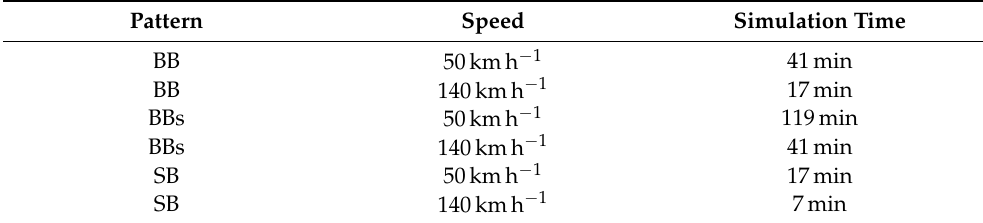
Figure 8. FE model with the roadway as master and the tread block as slave. A Top is the top side of the tread block. The simulation time depends strongly on the pattern used and especially on the driving speed, since the contact time increases inversely proportional to the driving speed. Simulations with one core and an Intel(R) Xeon(R) Gold 6134 CPU (3.2 GHz) result in the simulation times shown in Table 2. The increased simulation effort due to the lamellas is clearly visible. On the one hand, this is due to the self-contact between the individual lamellae and on the other hand to the larger deformations in total. Table 2. Simulation time in A BAQUS depending on pattern layout and driving speed when using an Intel(R) Xeon(R) Gold 6134 CPU